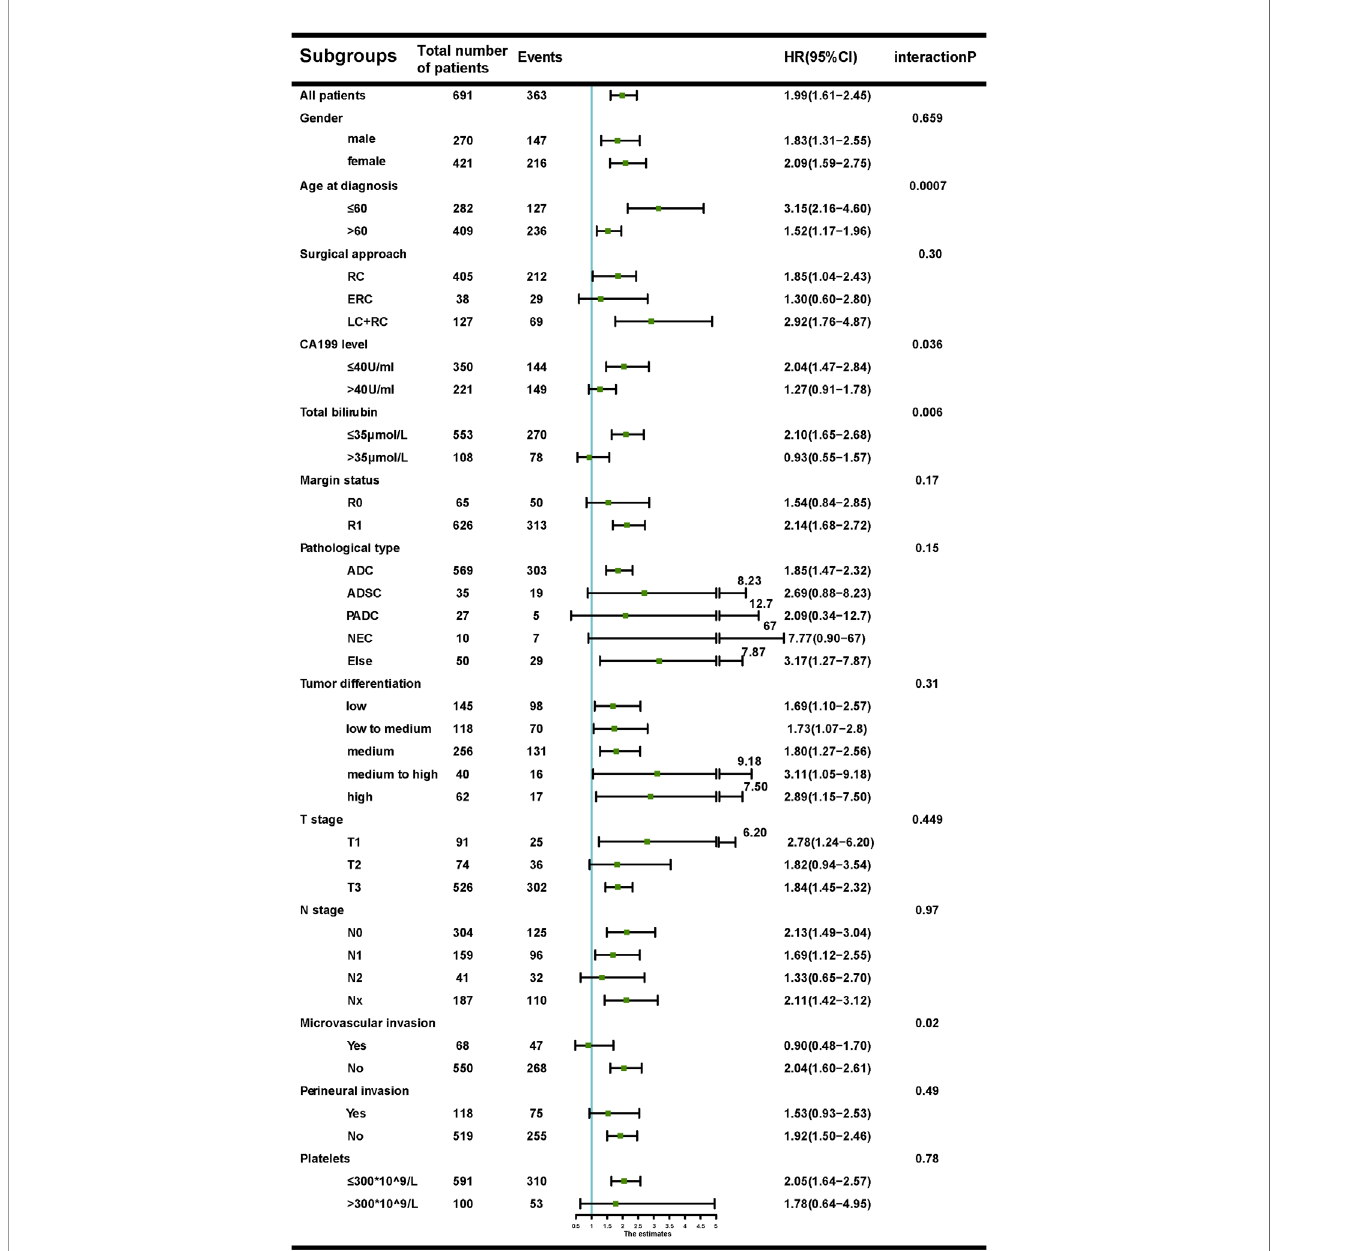
FIGURE 1 | Forest plot of the association between systemic immune-in fl ammation index (SII) and overall survival (OS), according to different